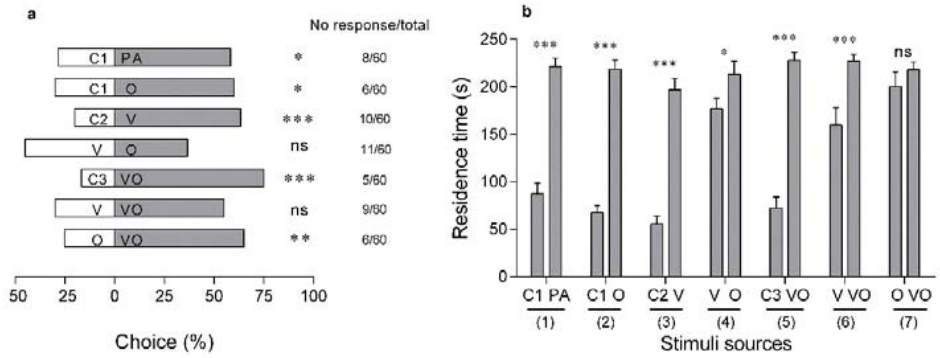
Figure 6. Behavioral responses of female western flower thrips, Frankliniella occidentalis to visual and olfactory cues. ( a ) Choice of thrips in a Y-tube olfactometer when exposed to di ff erent stimuli (Chi-square test, p < 0.05); ( b ) resident time of thrips in the two arms of the Y-tube olfactometer when exposed to di ff erent stimuli ( t -test, p < 0.05). Visual cue (V): yellow flower- shape; olfactory cue (O): extracted volatiles from flowering Medicago sativa ; combination of visual and olfactory cues (VO): combined volatiles of M. sativa with yellow flower -shape; PA: p -anisaldehyde; C1: hexane; C2: black